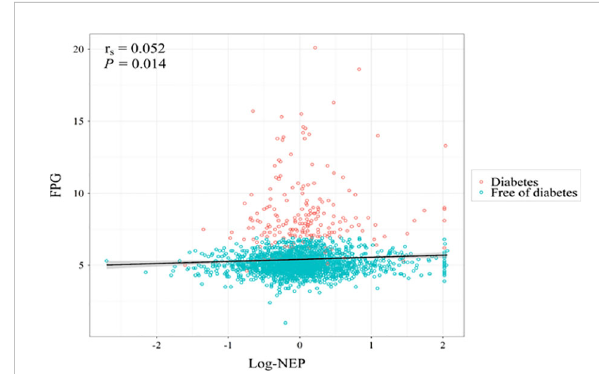
FIGURE 2 A scatterplot illustrating the association between serum neprilysin and fasting plasma glucose at baseline. Legend: The spearman correlation analysis found a signi fi cant correlation between serum neprilysin and fasting plasma glucose at baseline (r s =0.052, P =0.014). Red circles indicate individuals with diabetes and blue circles indicate individuals free of diabetes at baseline. After further adjustment for age, sex, education level, cigarette smoking, alcohol consumption, body mass index, systolic blood pressure, low- and high-density lipoprotein cholesterol, and hypoglycemic medication, the association was still signi fi cant ( b =0.08, P =0.004). FPG, fasting plasma glucose; log-NEP, log-transformed serum neprilysin; r s , spearman correlation coef fi cient.